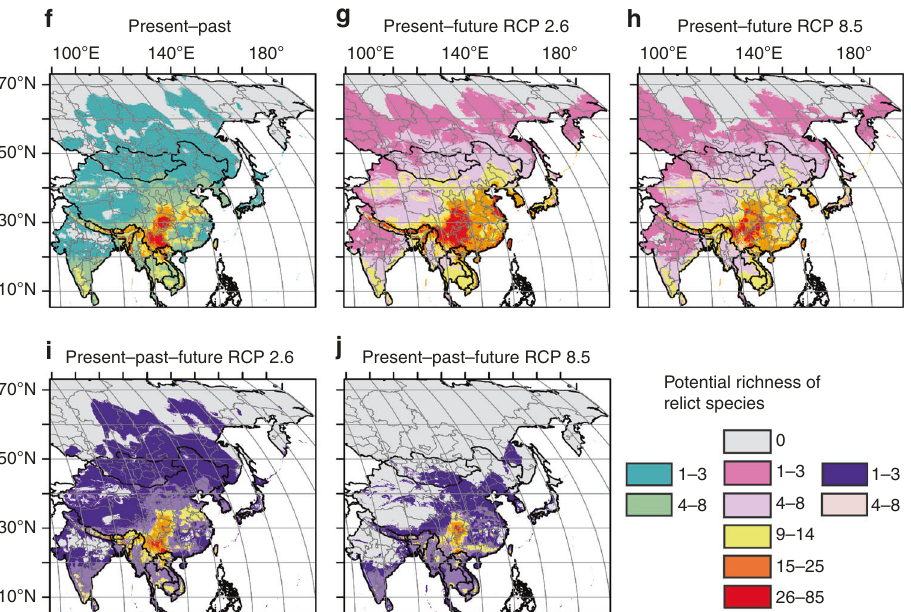
Fig. 5 Overlap of potential richness of relict species of the four time frames climatic scenarios. a – e For relict species of genera endemic to East Asia: a Overlap of the present and the past (LGM, mid-Holocene); b , c Overlap of the present and the future (2070) (under scenarios of RCP 2.6 for b , RCP 8.5 for c ); d , e Overlap of the present, the past and the future (under scenarios of RCP 2.6 for d , RCP 8.5 for e ). f – j For relict species of genera having disjunct distributions: f Overlap of the present and the past; g , h Overlap of the present and the future (under scenarios of RCP 2.6 for g , RCP 8.5 for h ); i , j Overlap of the present, the past and the future (under scenarios of RCP 2.6 for i , RCP 8.5 for j ). For the national boundary between China and India, please see Supplementary Fig. 2A and Methods. Maps were generated using the software ArcGIS v. 10.5 (ESRI, Redlands, CA, USA) and modi fi ed using Canvas 12 (ACD Systems of America, Inc., Seattle, WA, USA). Map layers were obtained from site